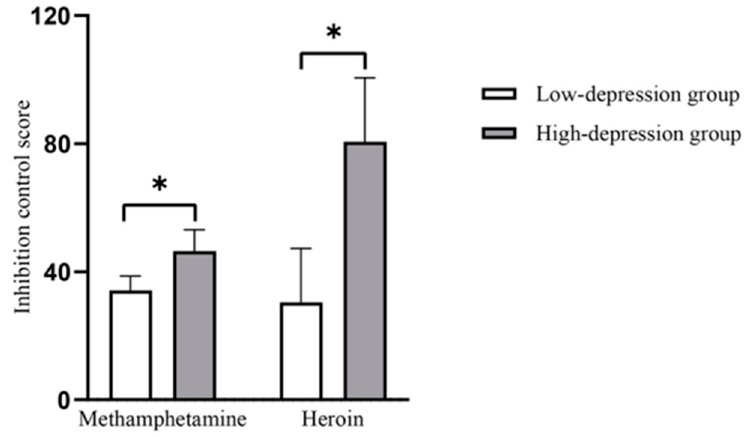
Figure 1. Inhibitory control scores in the between ‐ subject groups. Note: * p < 0.05.